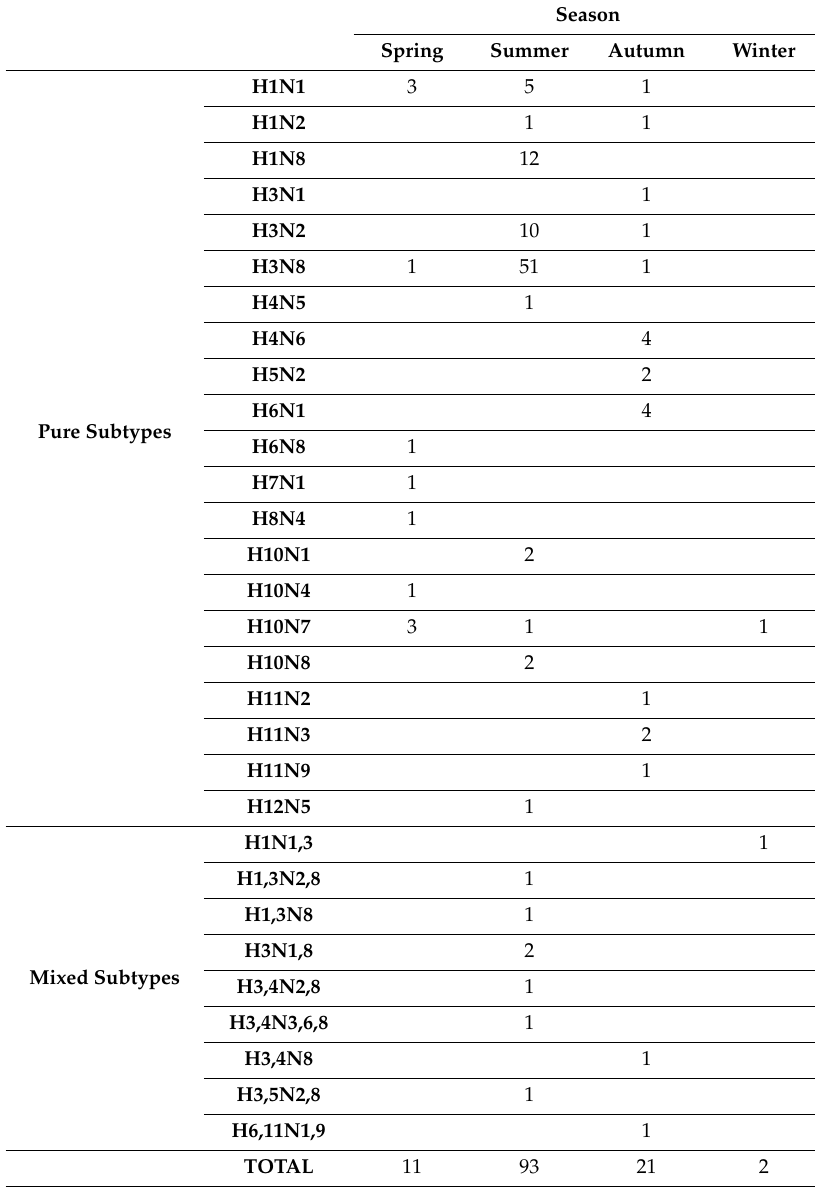
Table 1. Influenza A virus (IAV) subtypes recovered from wild mallards near Port Clinton, Ohio, USA by season. Active IAV surveillance in wild mallards ( Anas platyrhynchos ) was conducted year-round July 2017–July 2019 in an attempt to fill a gap in surveillance during the spring season. IAV subtypes isolated from mallards are shown by season. Both pure and mixed subtypes were isolated throughout the study